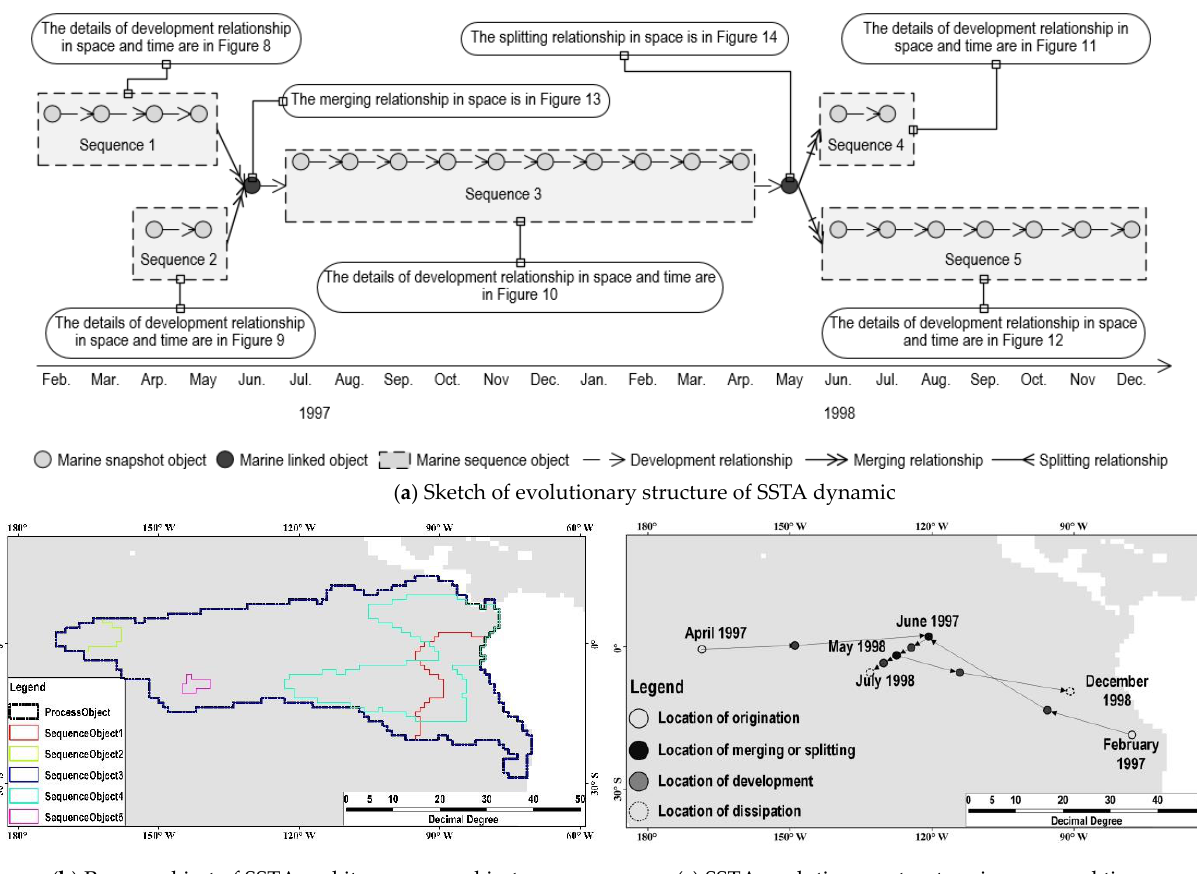
Figure 14. Linked object in May 1998, in which sequence object 3 splits sequence object 4 and object 5 in the Equatorial Eastern Pacific Ocean. The background is the monthly SSTA.